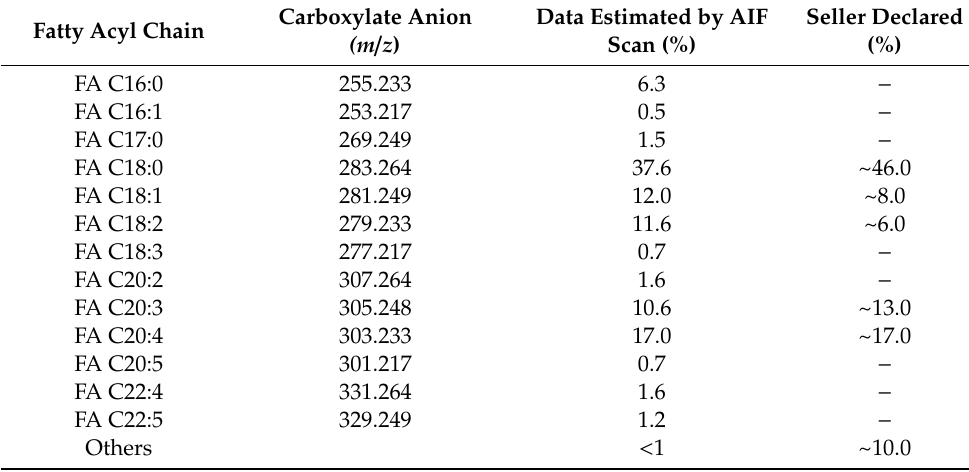
Figure 3. ( A ) Full MS spectrum and ( B ) AIF MS spectrum obtained by spectral averaging under the phosphatidylinositols (PI) band following HILIC-ESI-FTMS analysis of a mixture extracted from bovine liver. Table 1. Distribution of fatty acids estimated for a commercial mixture of phosphatidylinositols extracted from bovine liver, as inferred from the PI-related AIF MS scan obtained after HILIC-ESI-FTMS analysis. The FA distribution declared in the PI mixture information sheet is reported in the last